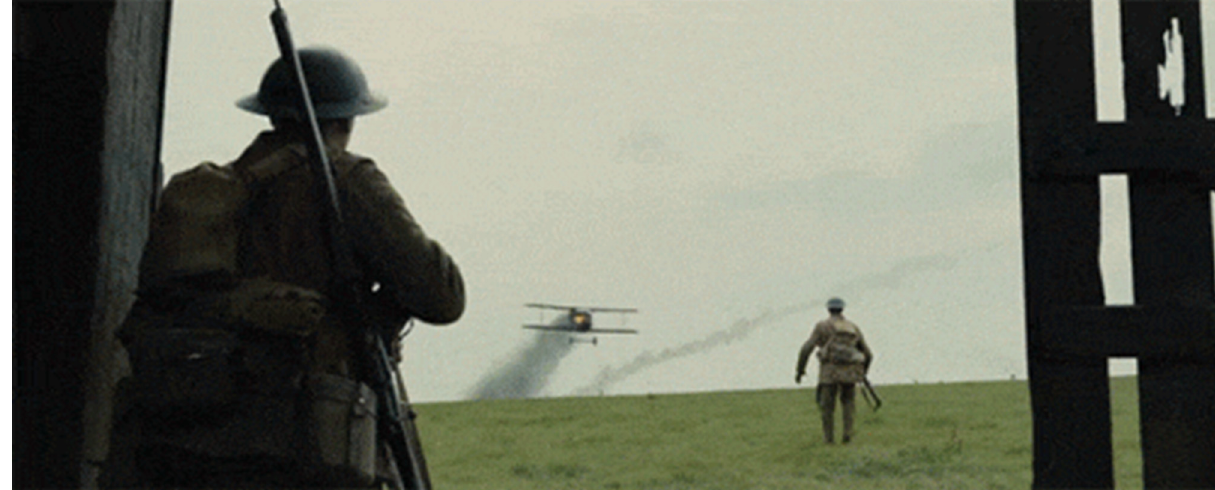
Figure 11. Or seek cover from an approaching enemy.